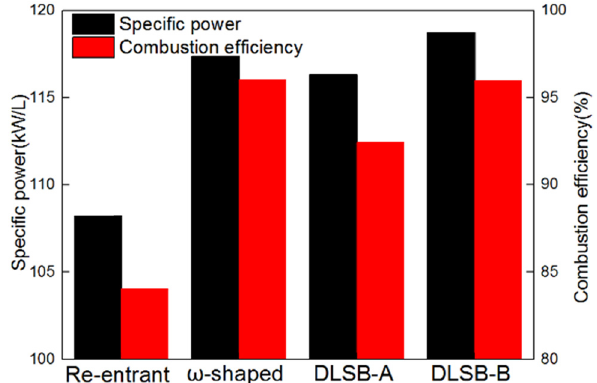
Figure 10: Speci fi c power and combustion e ffi ciency for di ff erent piston